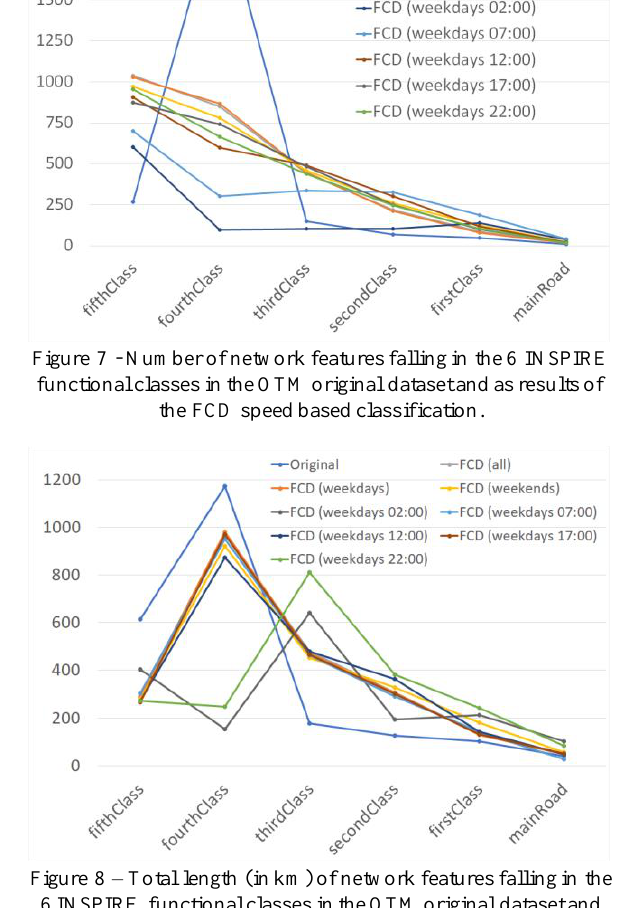
Figure 5 – Dynamic functional classes, for a working day at 7:00 AM (a) and at 10:00 PM (b)